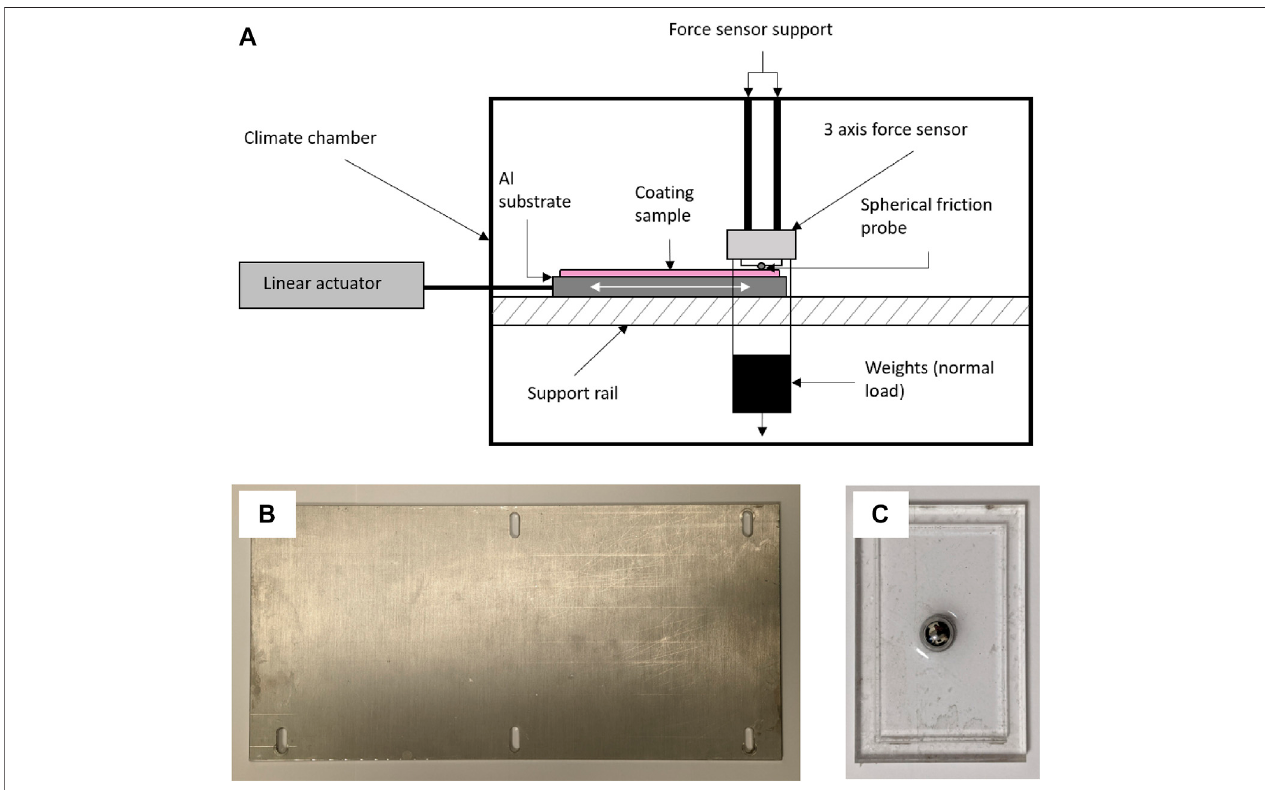
FIGURE1|(A) Schematicdrawingofthefrictiontestrig,adaptedfromO ’ Neilletal.(2021). (B) Aluminiumsubstratepriortobeingcoated.Itsdimensionsare33 cm by 16 cm. (C) Steel sphere (used as the friction probe) with a diameter of 80 mm partially embedded in an acrylic well and attached with a two-part epoxy resin.